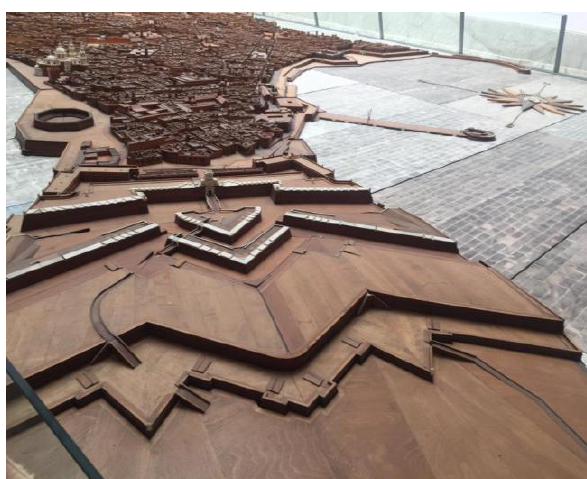
Figure 12. Photograph of the Land Front area of the Cadiz model as of 1779. Museum of the Cortes de Cadiz. Photograph by F.